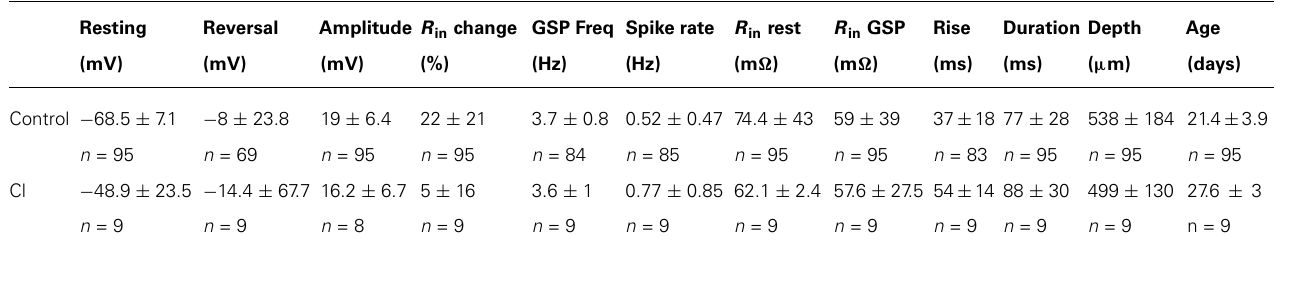
Table 1 |A summary of the cells’ characteristics using different intracellular